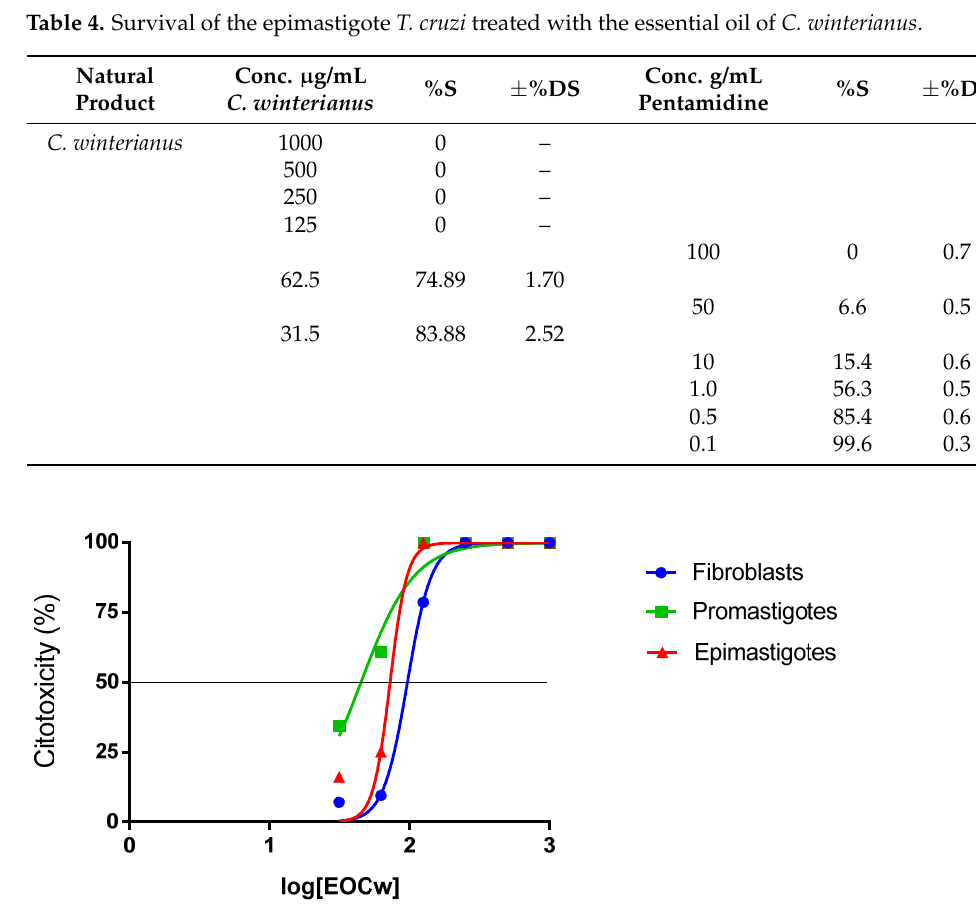
Table 4. Survival of the epimastigote T. cruzi treated with the essential oil of C. winterianus. Conc. µg/mL Natural Product